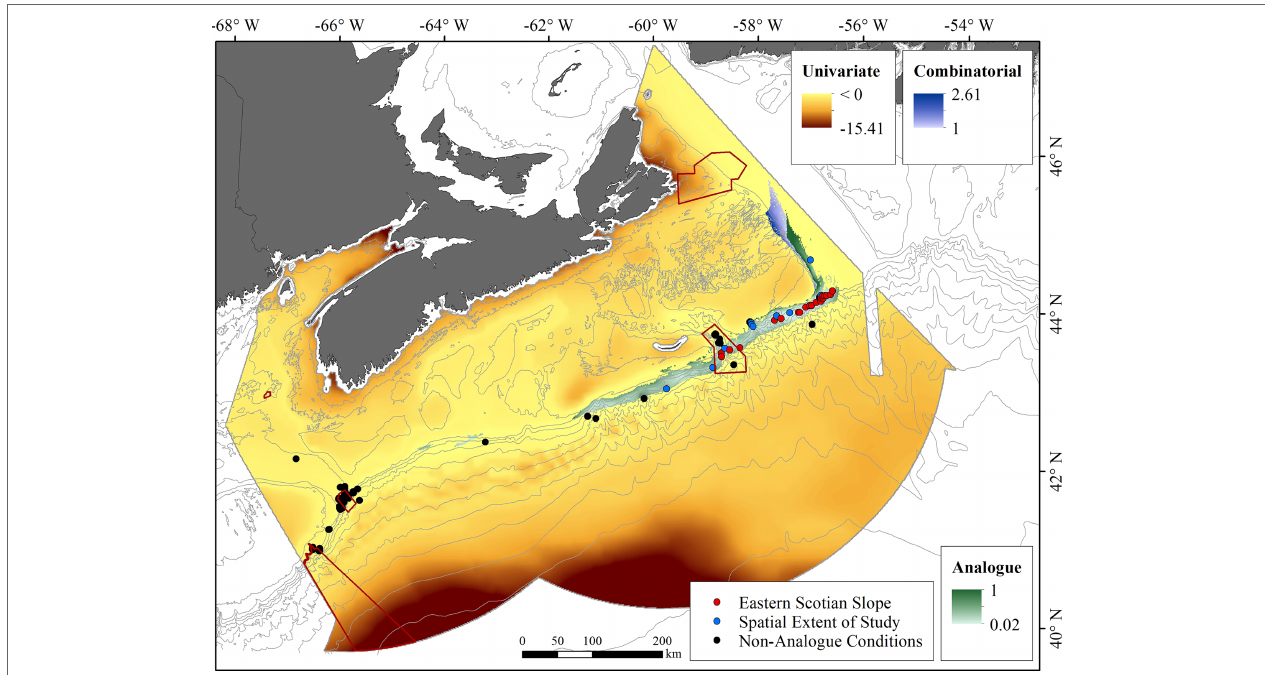
FIGURE 8 | Areas of analogous and non-analogous conditions under RCP 4.5 climate projections for 2046-2065, defined by eight input covariates, showing the locations of confirmed records of Paragorgia arborea coded by the projected future status of environmental conditions at those sites and existing conservation areas (in red outline). Locations of existing records that are projected to retain conditions analogous to those where the species presently occurs on the eastern Scotian Slope are shown in red. Locations which will retain, or change to, conditions analogous to those under which the species is presently found west of 60°W are shown in blue. Black dots mark records in areas projected to change to non-analogous